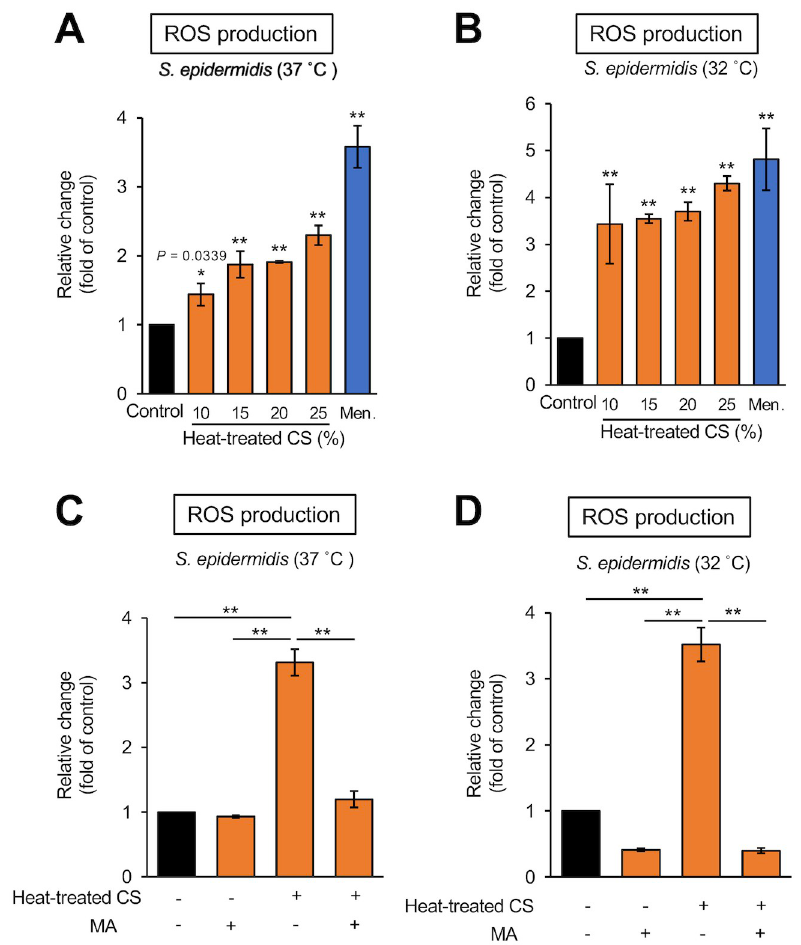
Fig 5. ROS production induced in S . epidermidis by heat-treated culture supernatant of D . acidovorans . (A, B) ROS production in S . epidermidis (1 × 10 6 cells/mL) mixed with NB (Control), 10–25% D . acidovorans heat-treated CS (Heat-treated CS), or 70 μ g/mL menadione (Men.) at 37˚C (A) or 32˚C (B) for 24 h. Menadione was used as a positive control. Fluorescence ( λ excitation = 485 nm, λ emission = 538 nm) was measured using the Fluoroskan Ascent ™ . Error bars indicate the SD of the means (n = 3). Statistical differences between groups were analyzed by the Dunnett test. ( � : P < 0.05, �� : P < 0.001). (C, D) ROS production in S . epidermidis (1 × 10 6 cells/mL) mixed with NB (Control), 4 mM malonic acid (MA), 25% D . acidovorans heat-treated CS (Heat-treated CS), or 4 mM MA + 25% heat-treated CS at 37˚C (C) or 32˚C (D) for 24 h. Fluorescence ( λ excitation = 485 nm, λ emission = 538 nm) was measured using the Fluoroskan Ascent ™ . Error bars indicate the SD of the means (n = 3). Statistical differences between groups were analyzed by the Tukey-Kramer test. ( � : P < 0.05, �� : P <